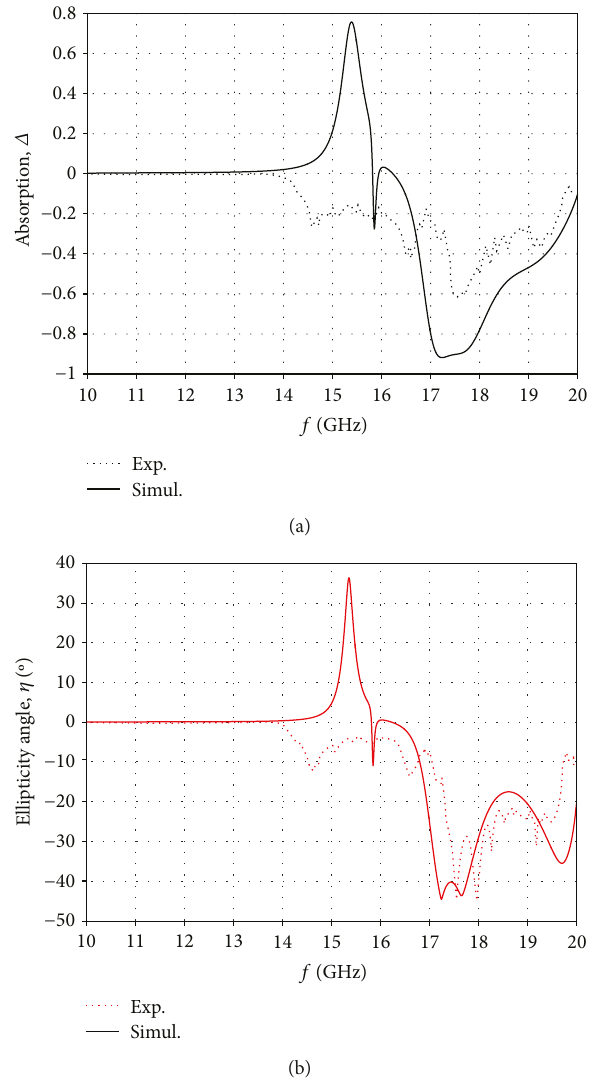
Figure 6: Variation of the simulated and measured absorption Δ (a) and ellipticity angle η (b) over the frequency band 10 – 20